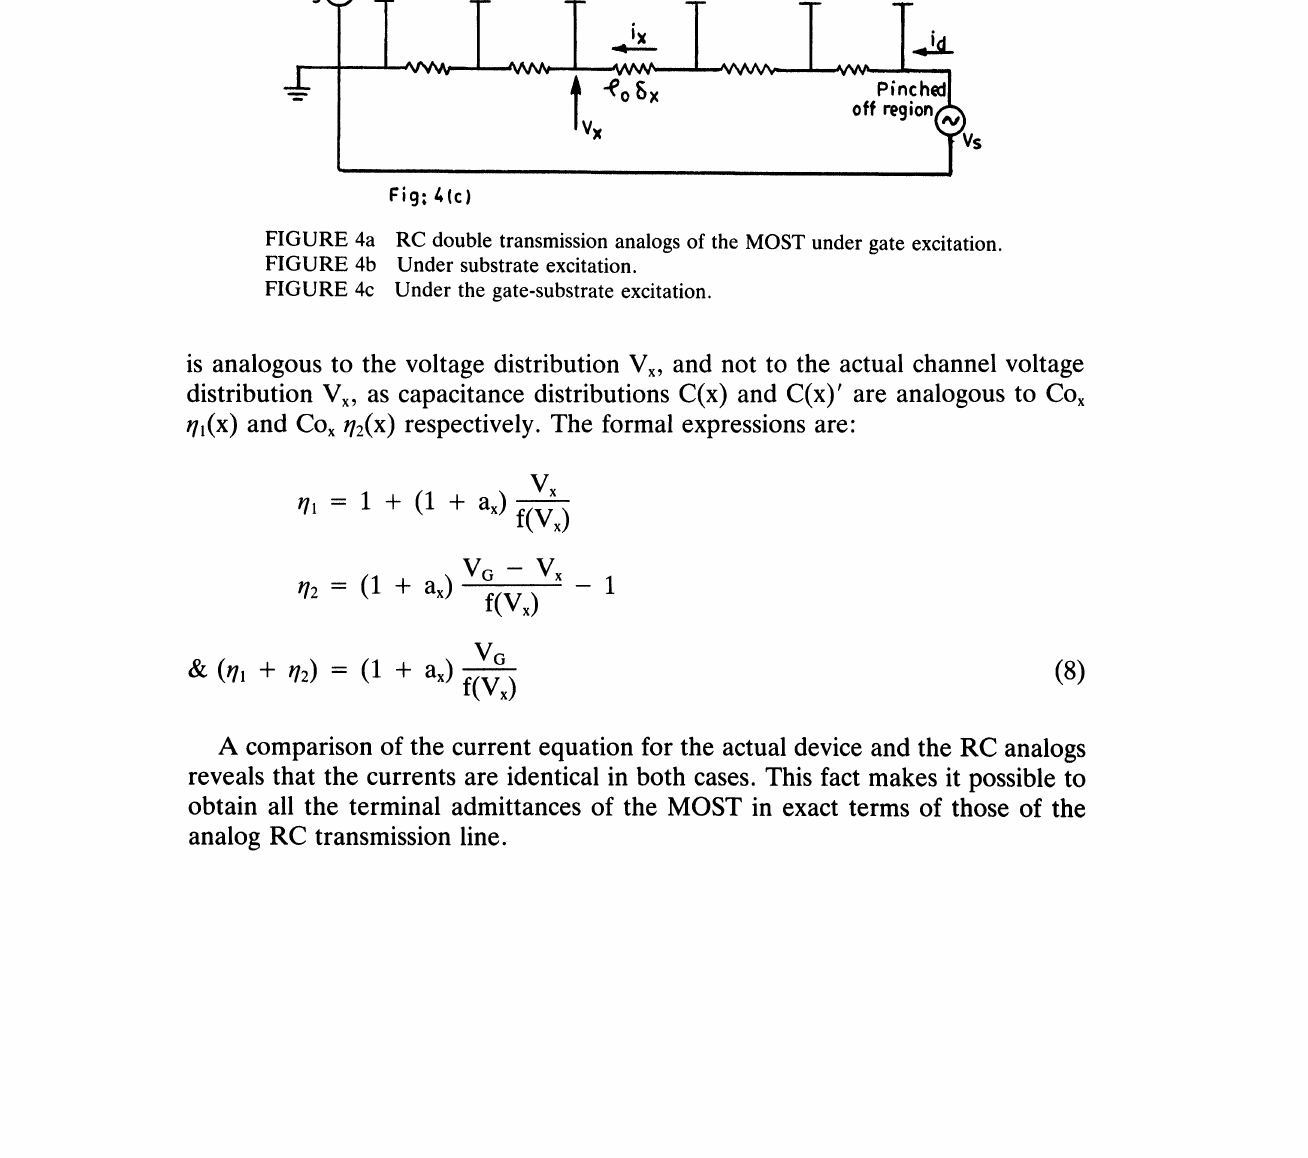
Pinche:lJ off region( Tvs